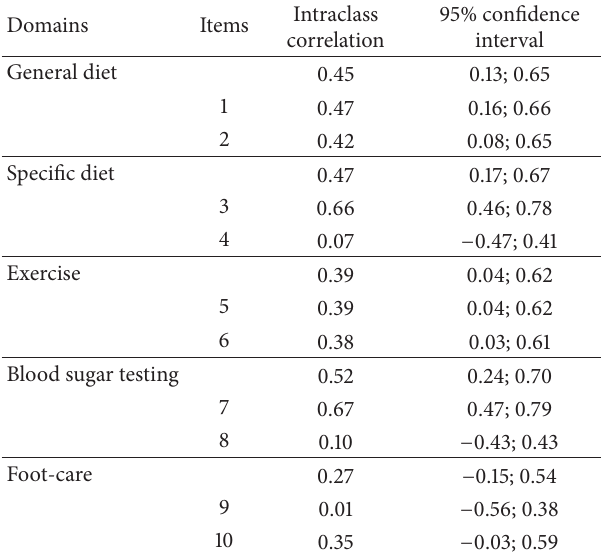
Table 5: Test-retest reliability of the Moroccan version of the Summary of Diabetes Self-Care Activities (intraclass correlation coefficient and 95% confidence